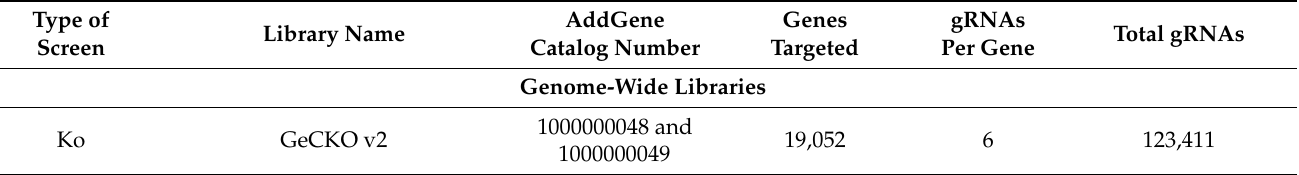
Table 1. Currently available pre-made CRISPR